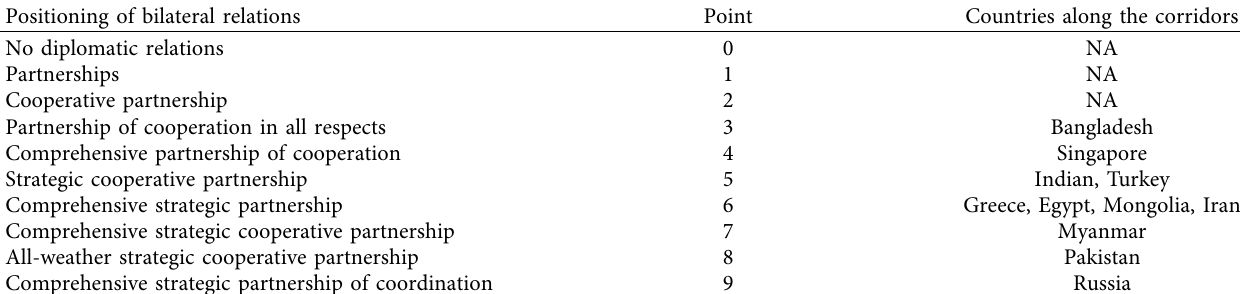
Table 4: Evaluating the relationship positioning between China and Ti.